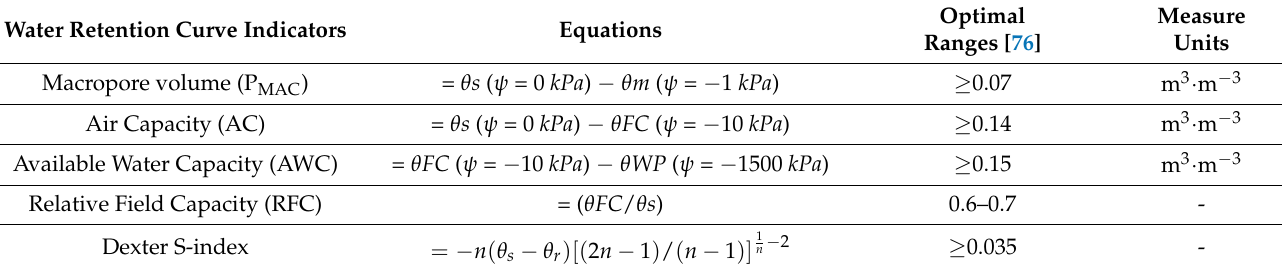
Table 2. Indicators calculated through water retention